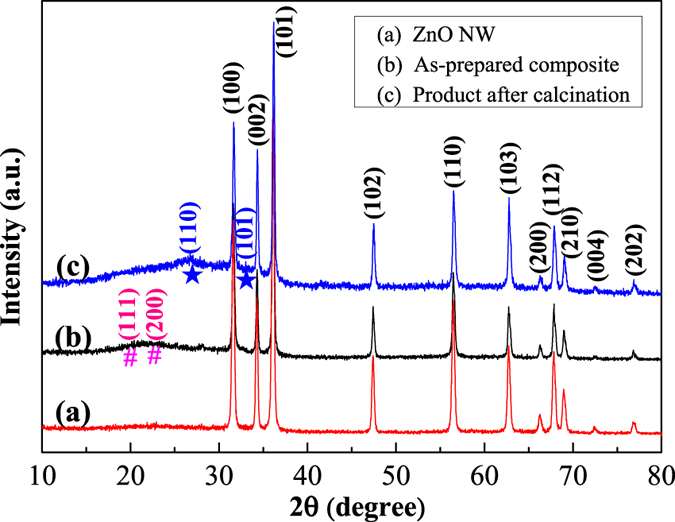
XRD pattern of (a) the pristine ZnO support, (b) the as-prepared ZnSn(OH)6/ZnO composite, and (c) the obtained SnO2/ZnO heterojunction.